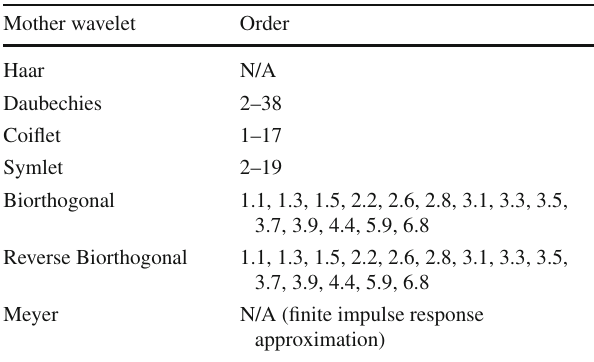
Table 1 Wavelet functions used for denoising in this work, including the mother wavelet and order (where applicable) Mother